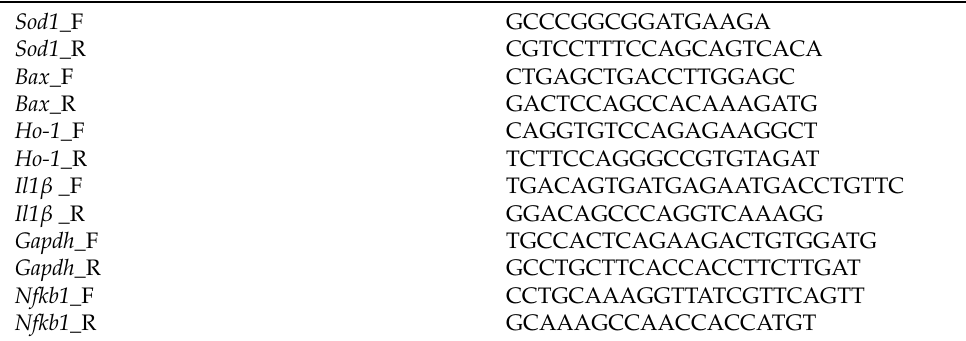
Table 2. List of primers for molecular